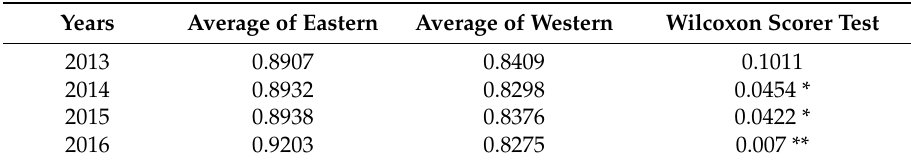
Table 2. Wilcoxon signed rank Test of average Technical